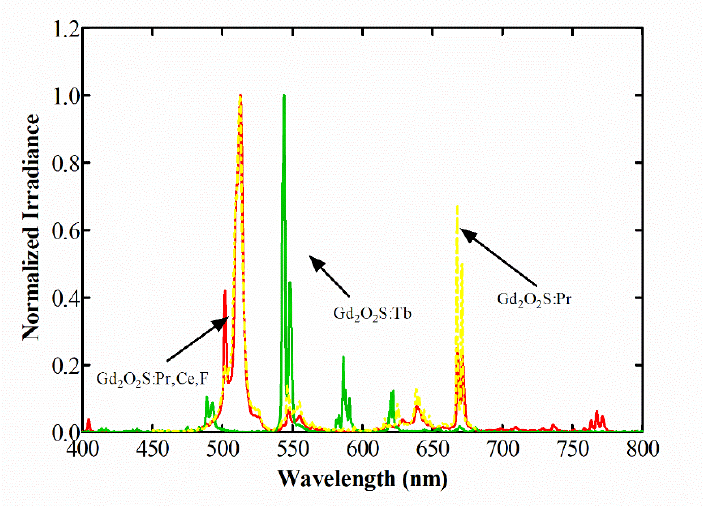
Figure 6. In the emission spectrum we can recognize the Gd 2 O 2 S:Tb screen with its main peaks at 475 nm and 550 nm; the Gd 2 O 2 S:Pr screen with its main peaks at 512 nm and 668 nm; and the Gd 2 O 2 S:Pr,Ce,F screen with its max peak at 513 nm.